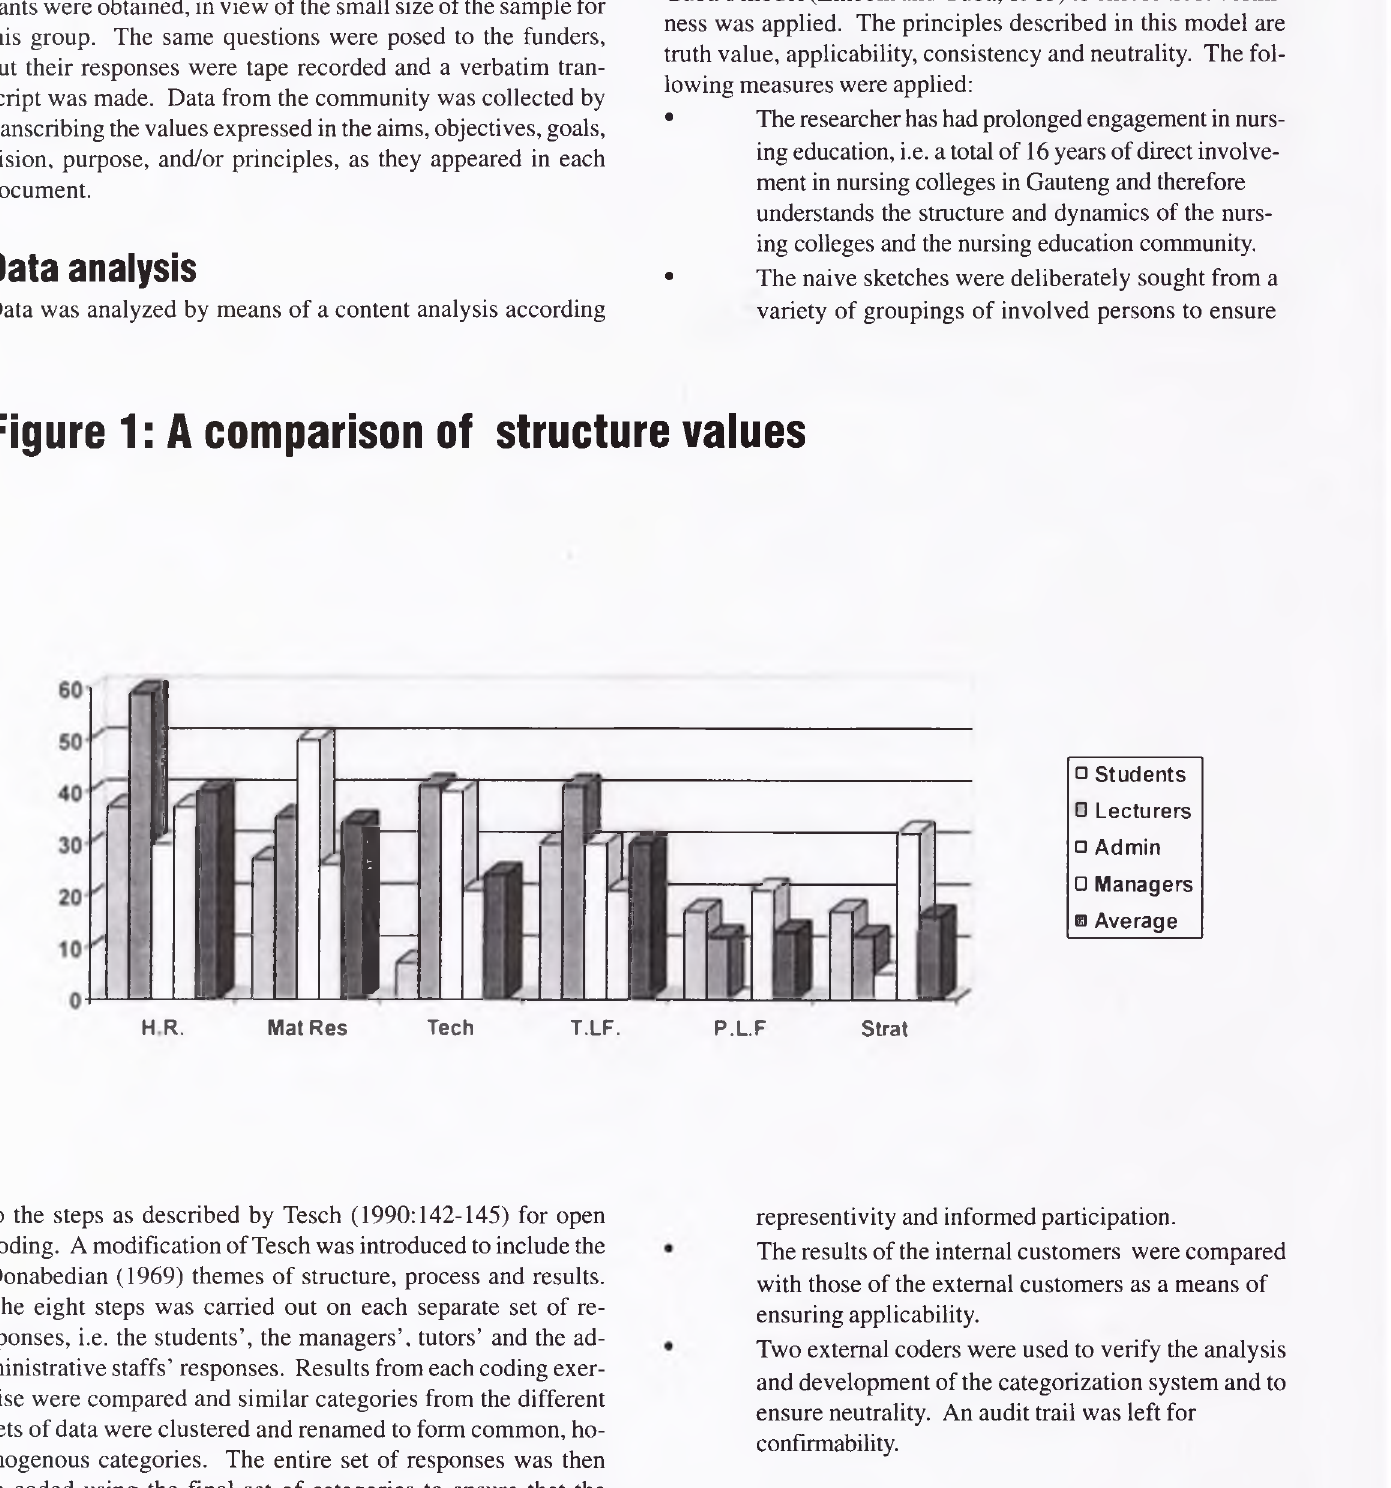
Figure 1 : A comparison of structure values